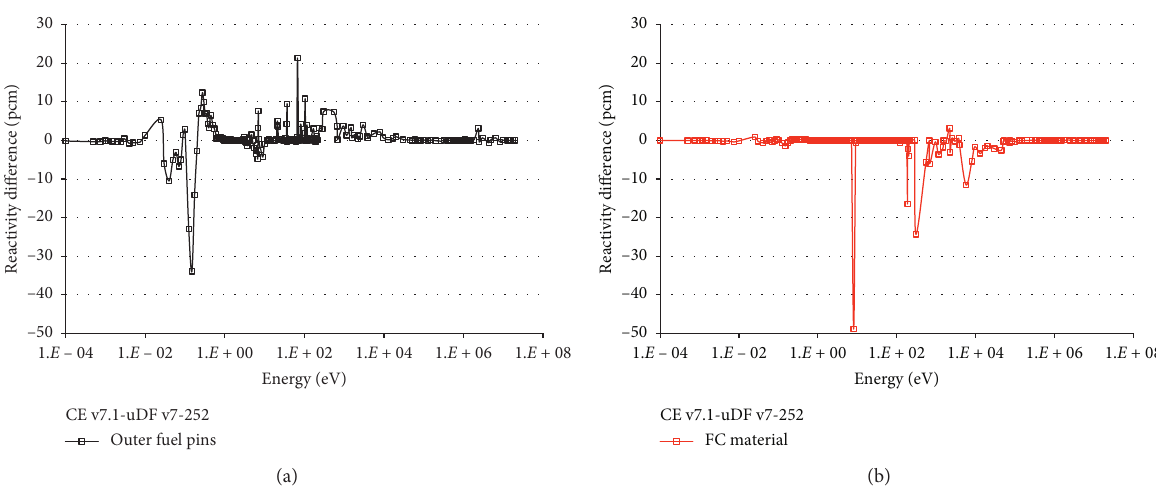
Figure 8: Δ ρ CE-uDF cases for separate regions.